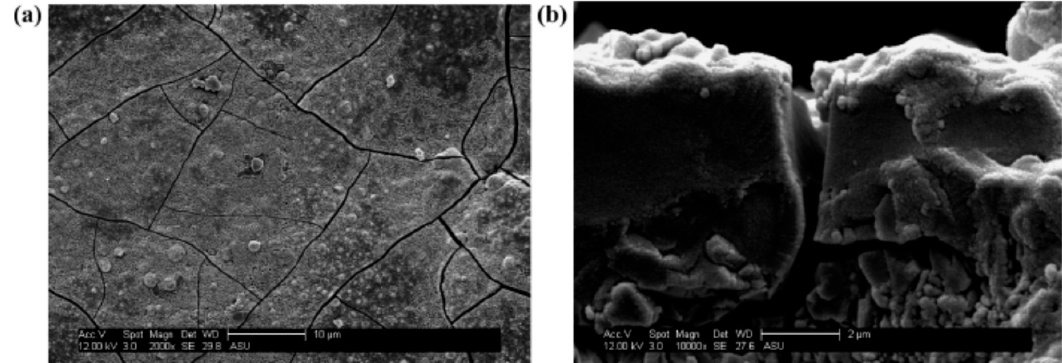
Figure 9. ZIF-68 membrane synthesis step following dip-coating of Al 2 O 3 support in ZnO. SEM micrographs of ZIF-68 membrane layer on Al 2 O 3 support following dip coating of ZnO, reactive seeding, and secondary growth at ( a ) 2000 × and ( b ) a cross-sectional view at 10,000 × ; Reproduced with permission from [18]. Table 6. Pervaporation performance of the ZIF-71 membrane in the separation of 5 wt% ethanol- water, methanol-water and DMC-methanol at 25 °C; Reproduced with permission from [80].